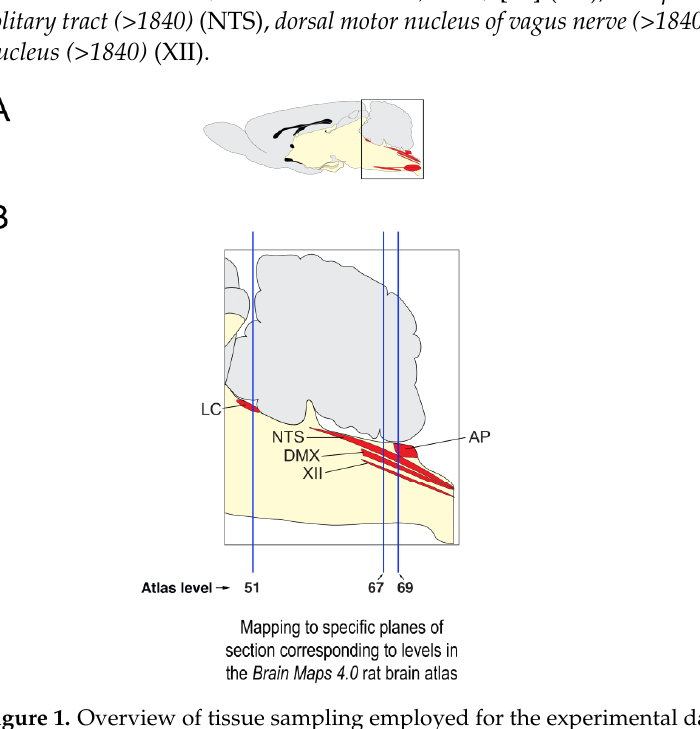
Figure 1. Overview of tissue sampling employed for the experimental dataset. ( A ) A sagittal-plane view of the rat brain, adapted from the Brain Maps 4.0 (BM4.0) open-access rat brain atlas [81], which is the spatial model we used in this study. ( B ) An enlargement is presented of the boxed outline shown in ( A ), which provides details concerning the portions of the rhombic brain (His, 1893) [21] (RB) we studied ( shaded in red ). These include the locus ceruleus (Wenzel and Wenzel, 1912) [82] (LC), area postrema (>1840) (AP), nucleus of solitary tract (>1840) (NTS), dorsal motor nucleus of vagus nerve (>1840) (DMX), and hypoglossal nucleus (>1840) (XII). Portions of these structures were identified in tissue sections as closely registered to specific atlas levels from BM4.0 ( shown as vertical blue lines ). See the methods section for details.